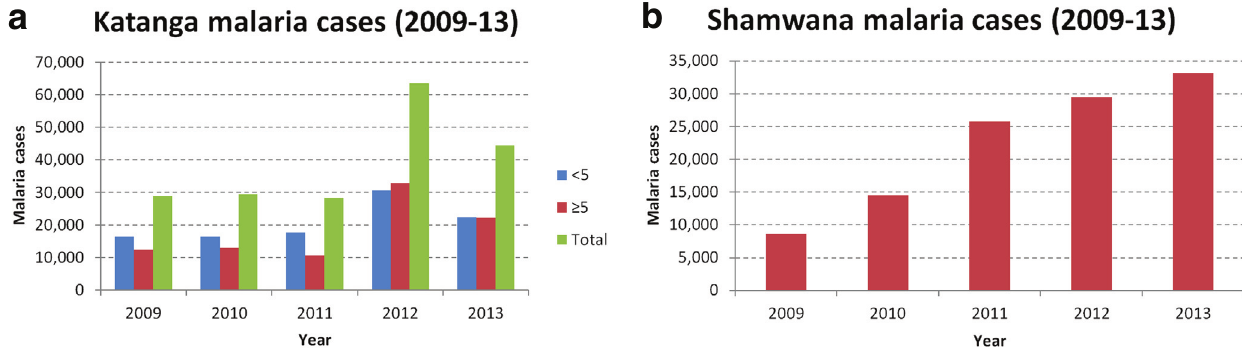
Figure 2. Confirmed malaria cases in Katanga and in Shamwana, Katanga in